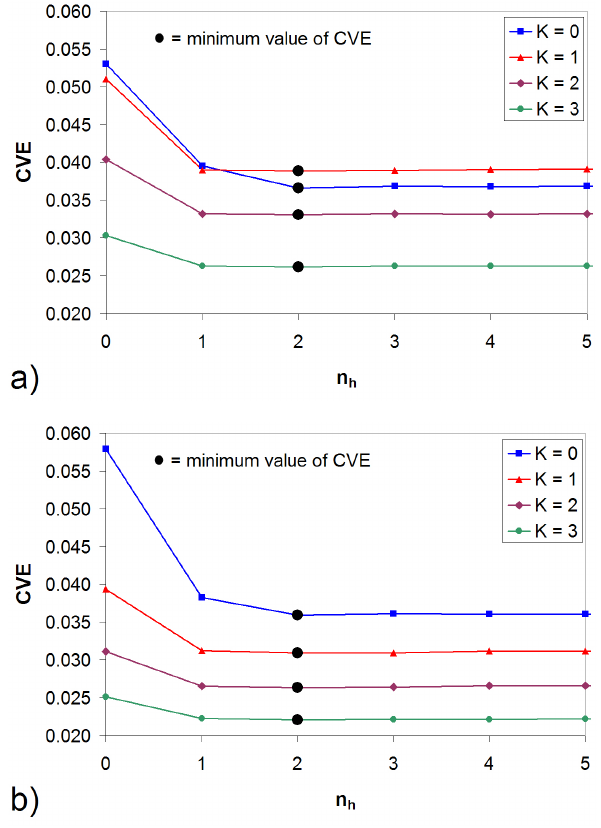
Fig. 5. Cross validated error (CVE) values estimated for each threshold value and the number of harmonics for (a) Cosenza and (b) Crotone rain gauges. The minimum CVE values occur for n h = 2.